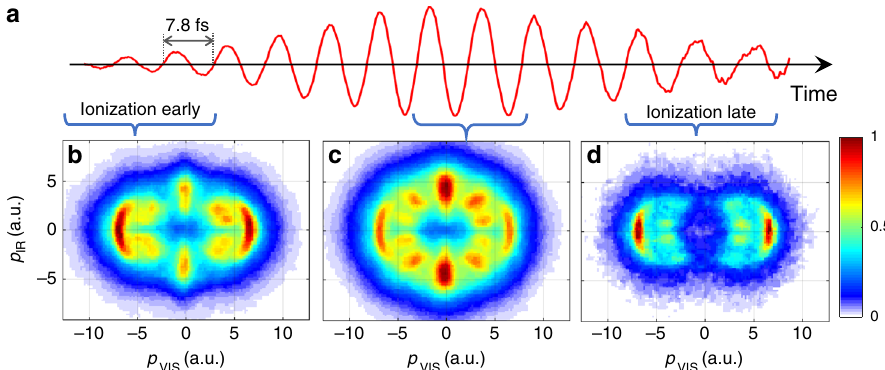
Fig. 4 Tracking the evolution of light-induced molecular potentials in H 2 + throughout a mid-IR laser pulse. a Vector potential of the mid-IR dressing fi eld measured using the STIER technique. b – d Measured H + momentum distributions in the polarization plane for different ionization times within the mid- IR pulse. The signal has been integrated over the delay ranges indicated by the brackets. The colorbar indicates the proton yield normalized to the maximum in each